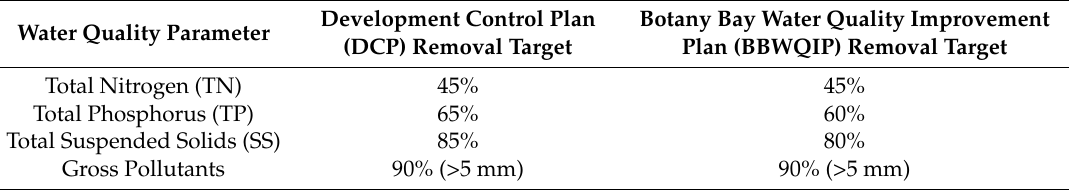
Table 1. Sydney’s stormwater improvement targets.